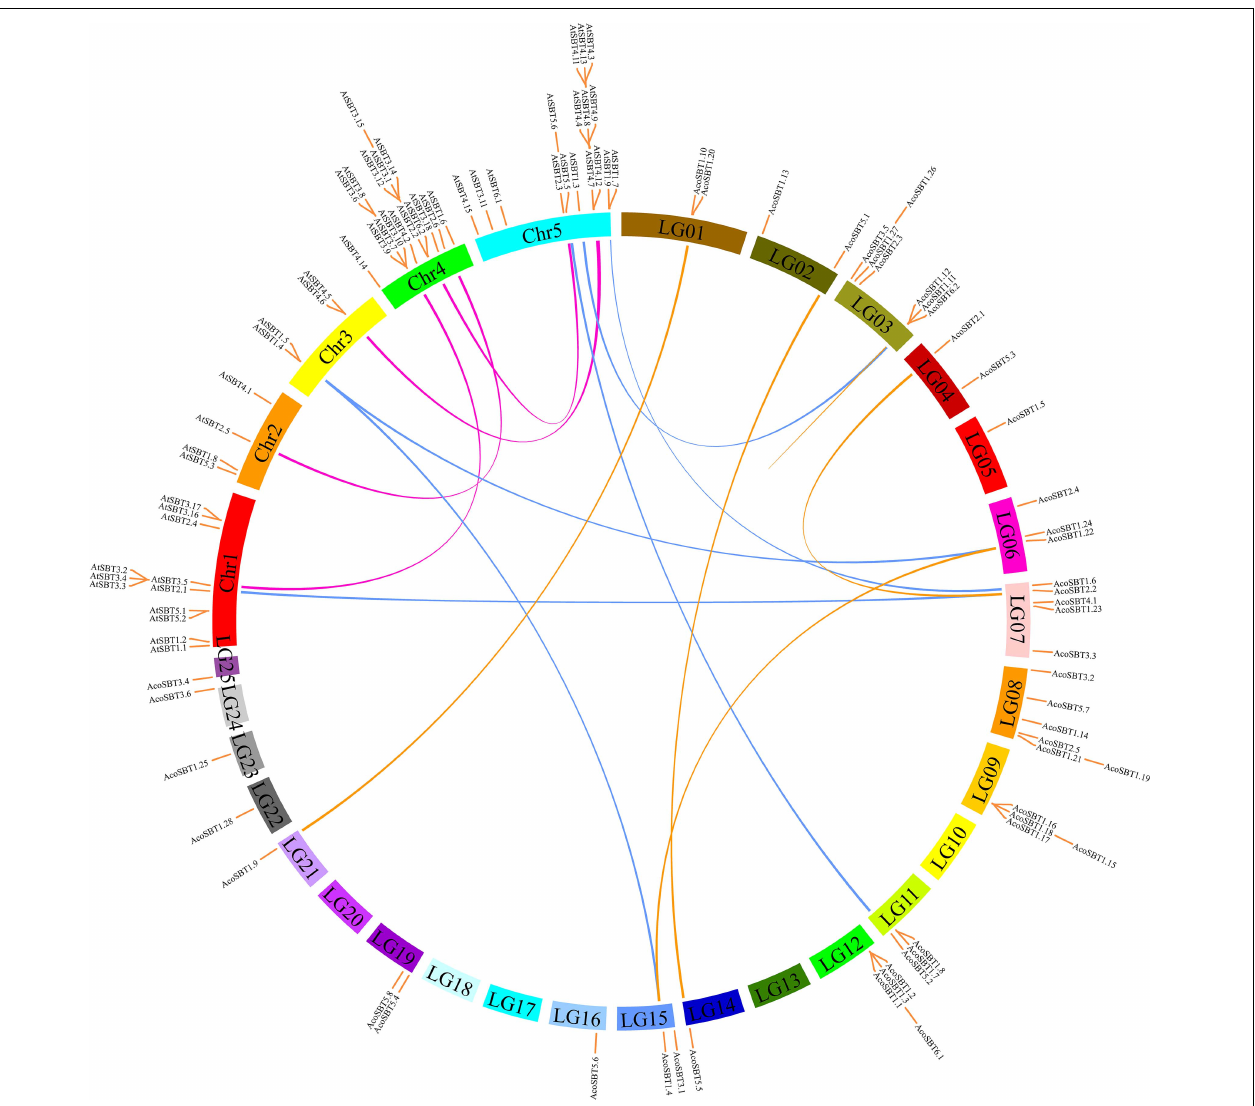
FIGURE 3 | Synteny analysis of SBT genes between pineapple and Arabidopsis. Schematic representation for both chromosomal distribution and interchromosomal relationships of SBT genes.